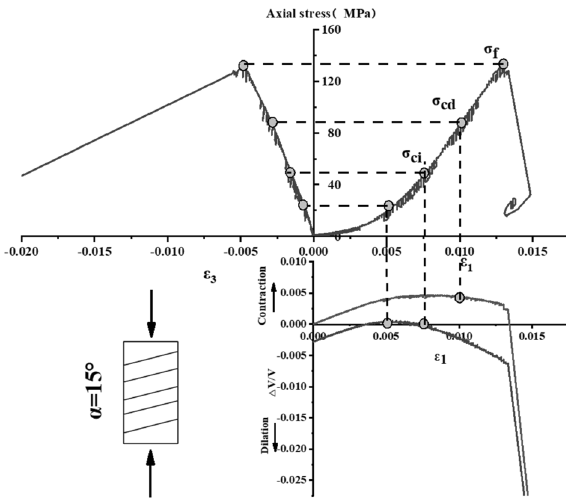
Figure 11. Progressive failure curve when the joint plane is α =